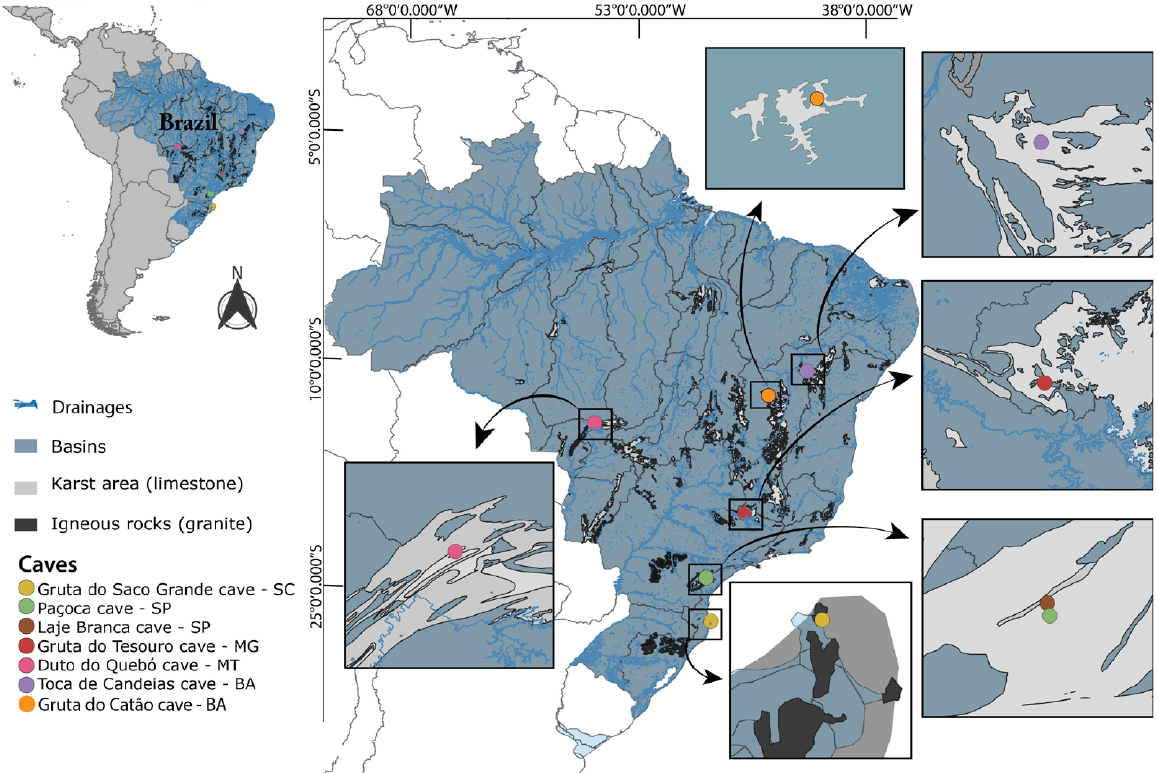
Figure 1. Map showing the location of the caves where the semiaquatic bugs were